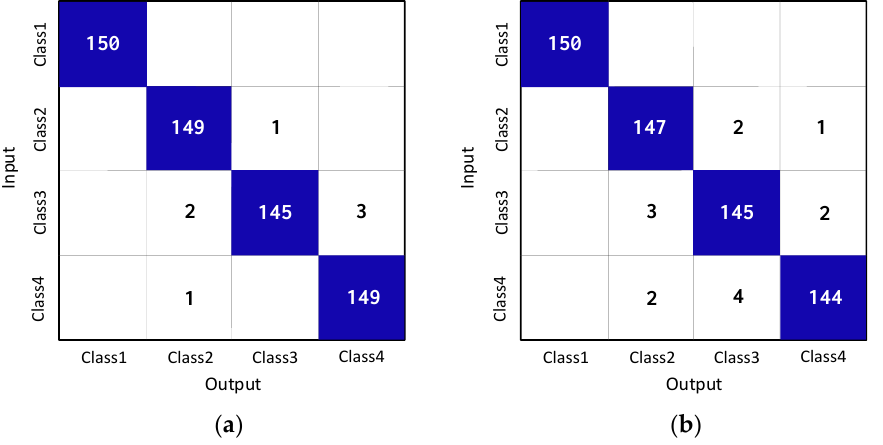
Figure 10. Confusion matrix results of CV-CNN and RV-CNN on test set. ( a ) CV-CNN, ( b ) RV-CNN.